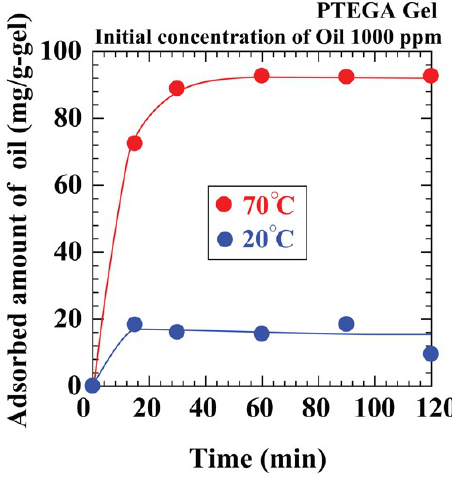
Figure 6. Effect of temperature on oil adsorption amount by PTEGA gel.